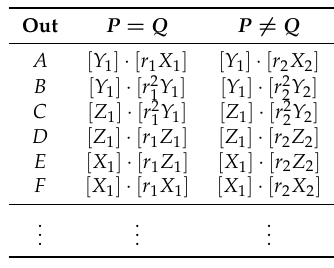
Table A6. Unified point addition for the Jacobi quartic elliptic curve